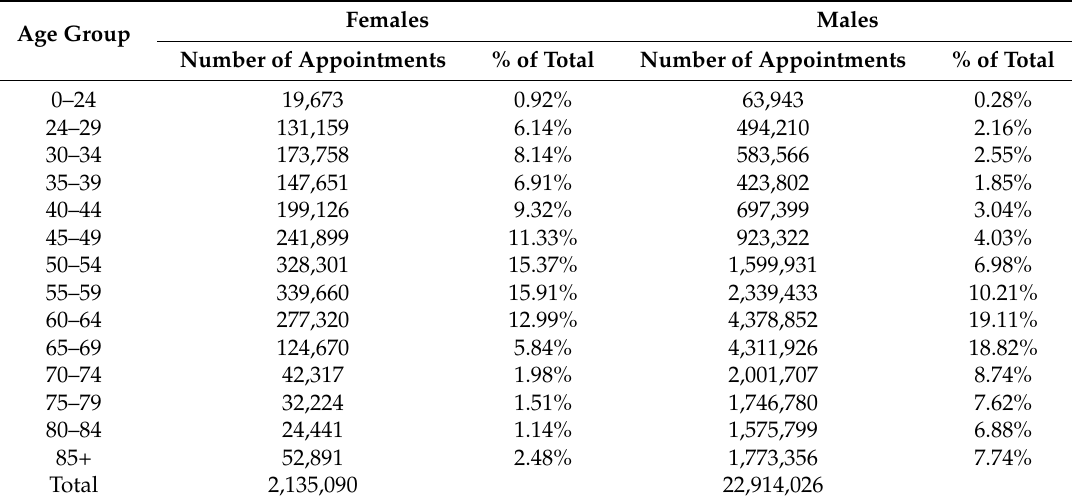
Table 2. Appointment frequencies for males and